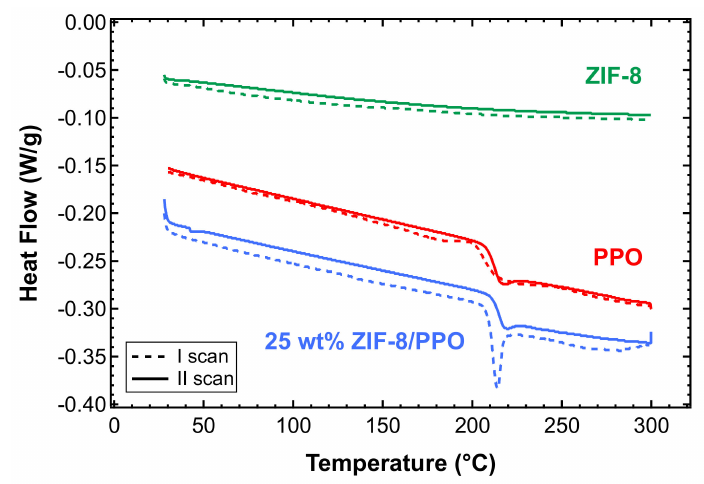
Figure 6. Di ff erential scanning calorimetry (DSC) tests on pure amorphous PPO film after a thermal annealing treatment at 200 ◦ C under vacuum (red), ZIF-8 powder as received (green), and 25 wt% ZIF-8 / PPO mixed-matrix film after undergoing a thermal annealing treatment at 200 ◦ C under vacuum